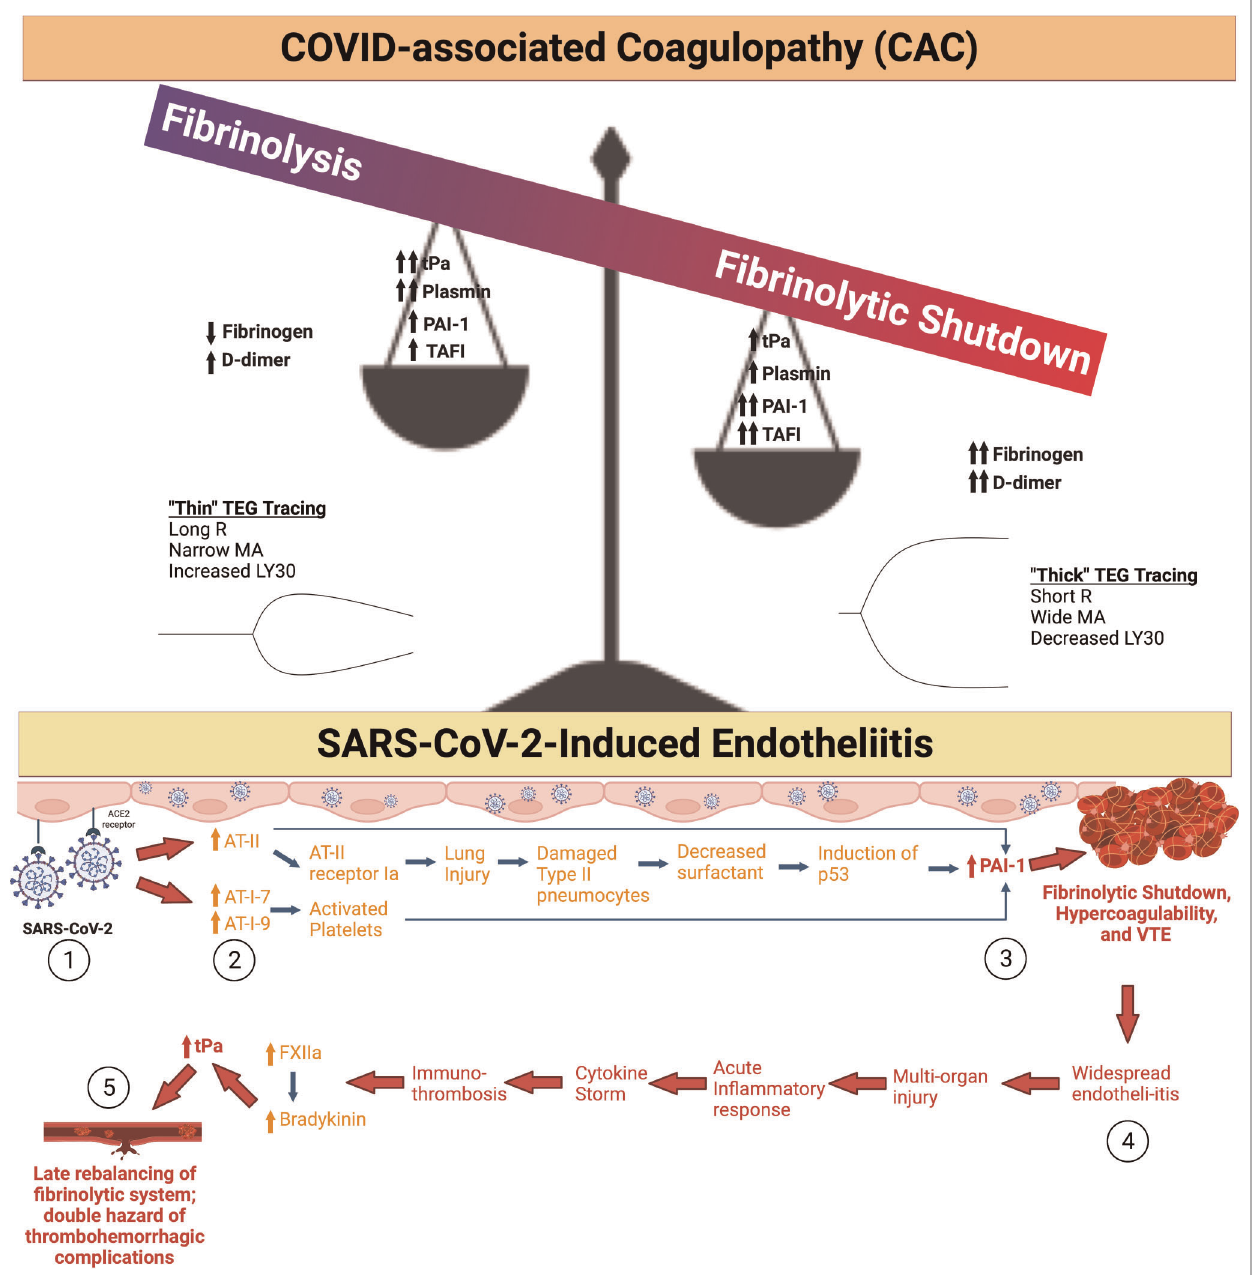
FIGURE 2 | COVID-19-associated coagulopathy (CAC) and Fibrinolytic Shutdown. (1) The SARS-CoV-2 Spike protein binds with angiotensin converting enzyme 2 (ACE2), which causes internalization of the receptor and virus into the host cell. (2) In turn, ACE2 is not available for breakdown of angiotensin II (AT-II) leading to its build-up. AT-II causes subsequent lung injury and increases in plasminogen activated inhibitor 1 (PAI-1). Angiotensin I-7 (AT-I-7) and angiotensin I-9 (AT-I-9) are increased by other pathways involving activated platelets, but also lead to increased levels of PAI-1. (3) Increased circulating PAI-1 leads to fi brinolytic shutdown, a hypercoagulable state characterized by increased fi brin deposition and thrombus formation. (4) Among other mechanisms, widespread endotheliitis and microthrombosis can cause multi-organ injury in patients with severe COVID-19 illness. This exacerbates the acute in fl ammatory response, often causing a cytokine storm and worsening immuno-thrombosis. In fl ammatory cytokines activate Factor XII (FXII), which subsequently increases bradykinin levels. Bradykinin increases tissue plasminogen activator (tPa) levels. (5) This subacute rebalancing of the fi brinolytic system predisposes the COVID-19 patient to both thrombosis and hemorrhage as a function of local endothelial derangement. This is particularly the case for hospitalized COVID-19 patients who are anticoagulated; these patients ’ anticoagulant regimen must be judiciously titrated on a personalized basis (17, 29, 31). The spectrum of fi brinolysis is depicted as a balance whereby the predominate hypercoagulable fi brinolytic shutdown phenotype is portrayed as a balance with high levels of PAI-1, thrombin activatable fi brinolysis inhibitor (TAFI), fi brinogen, D-dimer, and lower levels of tPa and plasmin. The opposite occurs at the opposite end of the fi brinolysis spectrum when fi brinolysis predominates, which occurs much less frequently in CAC. Created using BioRender.com